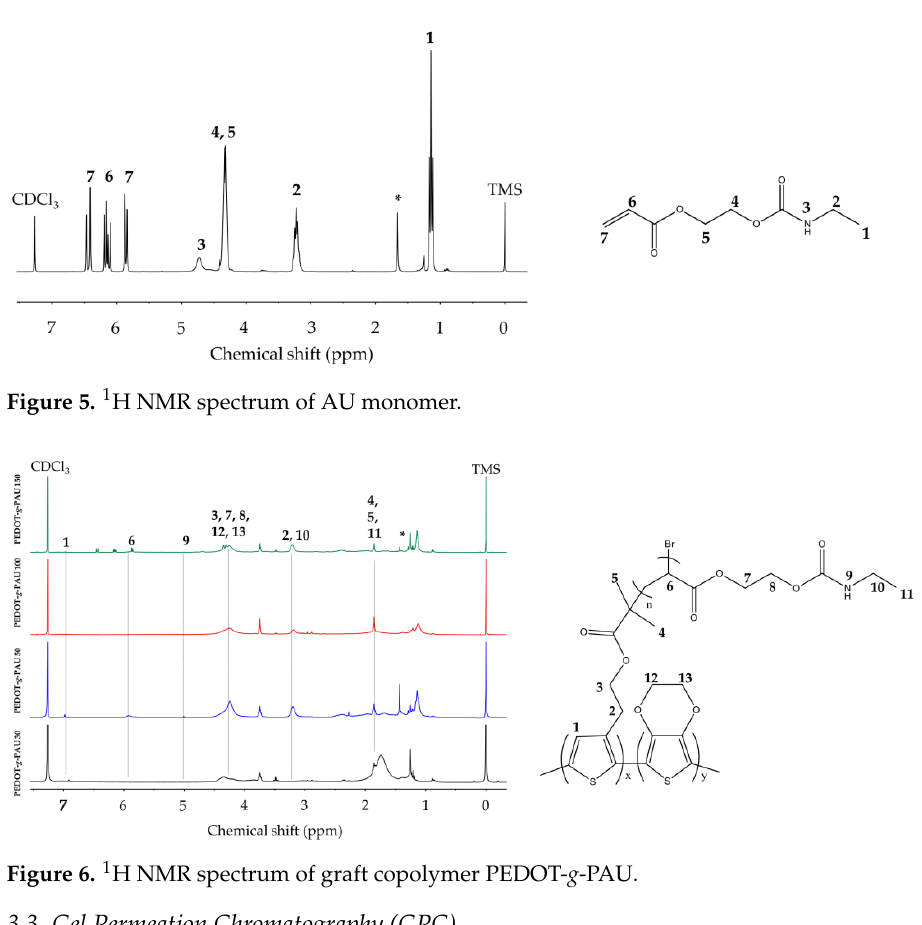
Figure 5. 1 H NMR spectrum of AU monomer.